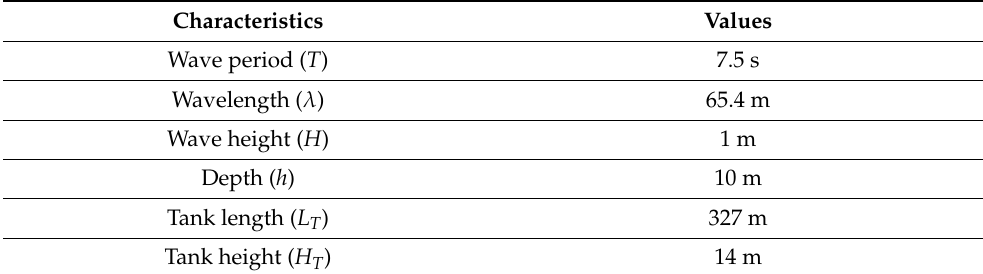
Table 2. Problem characteristics and wave